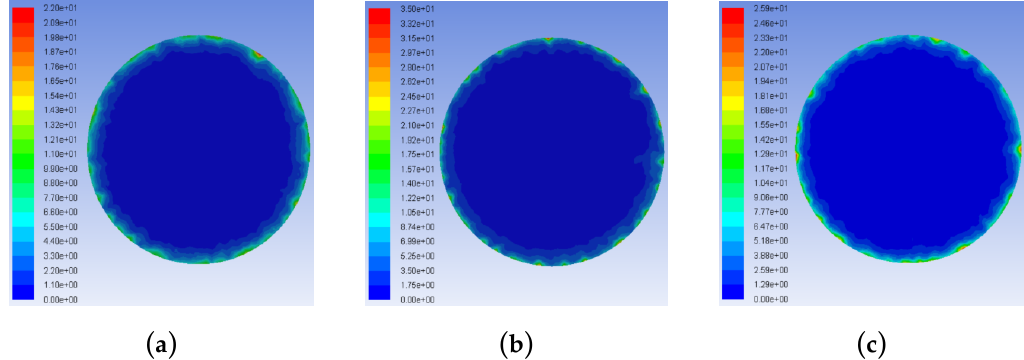
Figure 5. Concentration distributions of the processed products in the frontal machining gap: ( a ) Trapezoid; ( b ) rectangle; and ( c ) triangle.